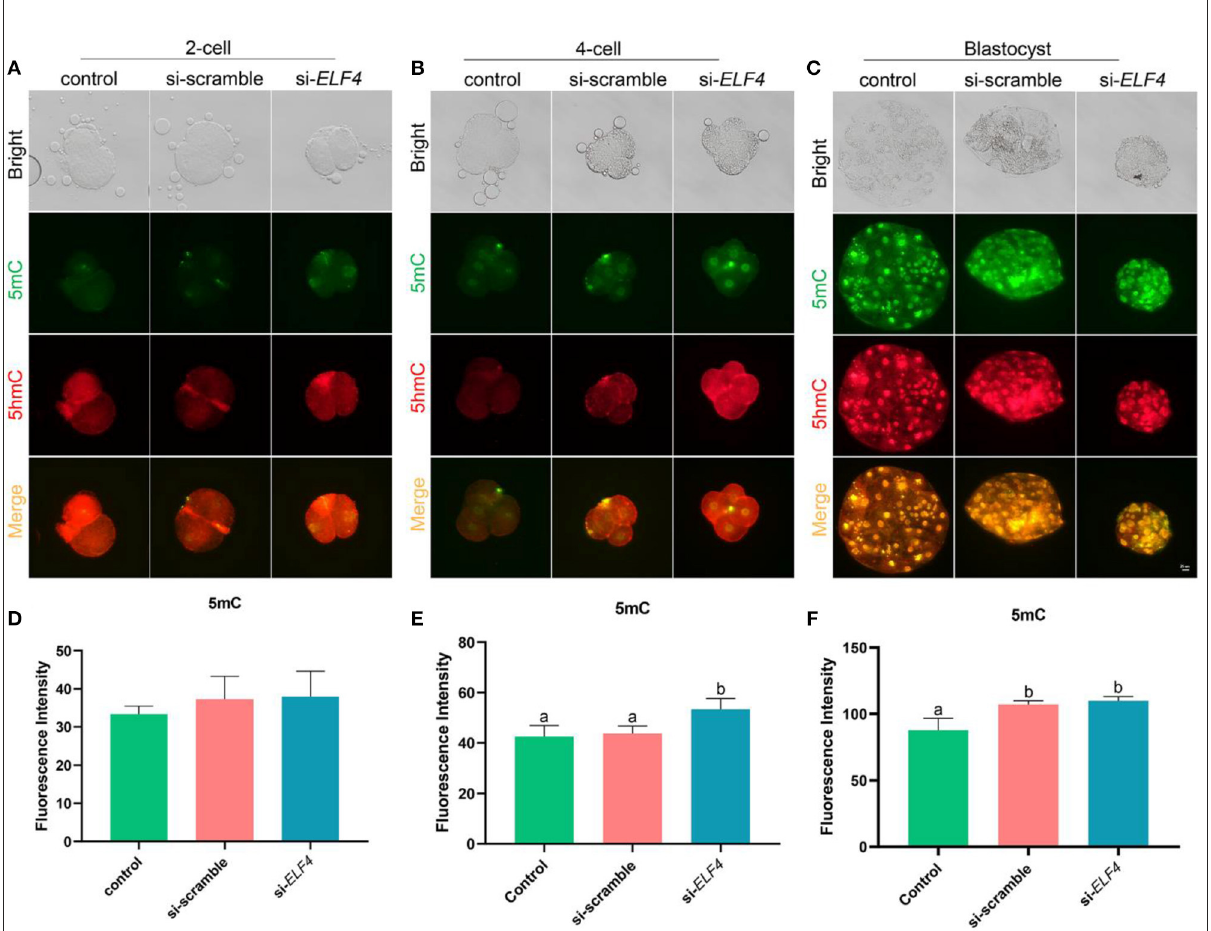
FIGURE7 Dynamic changes of DNA methylation at different stages of the preimplantation embryo after ELF4 knockdown. (A–C) Immunofluorescence staining of DNA methylation in the control, si-scramble, and si- ELF4 embryos. Scale bars represented 25 µ m. (D–F) Semi-quantitative fluorescence intensity analysis of the DNA methylation staining. Different lowercase letters indicate statistical differences ( p < 0.05).